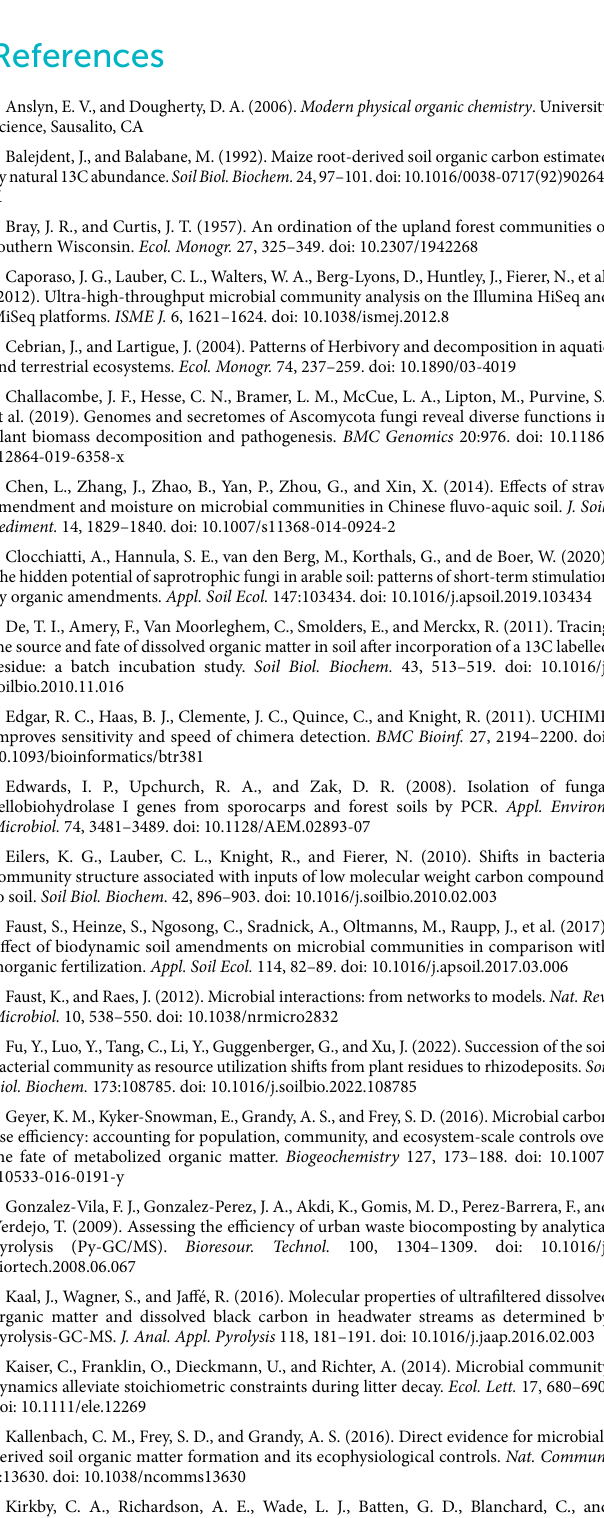
SUPPLEMENTARY FIGURE S4 Effects of bacterial and fungal diversity on microbial use efficiency of